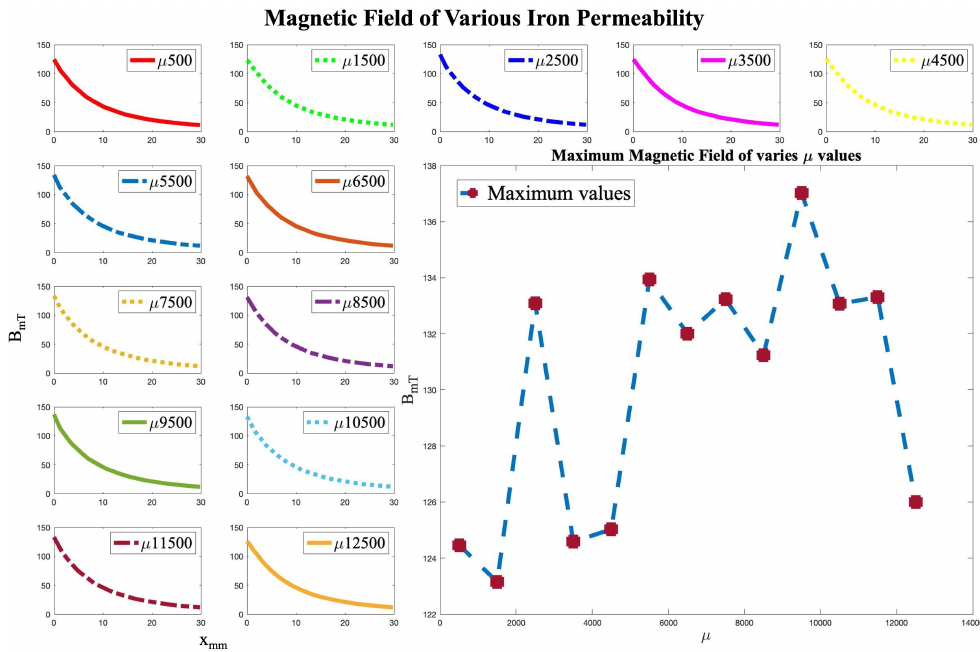
Figure 4. Simulated magnetic field for various magnetic